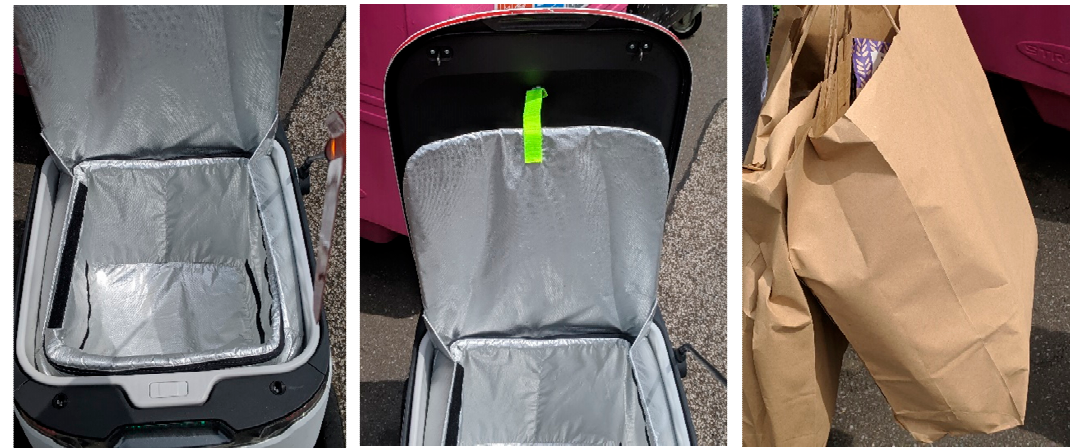
Figure 12. The inside of and the amount of shopping that fits inside a delivery Robot. Photograph taken and Permission granted by Marston.